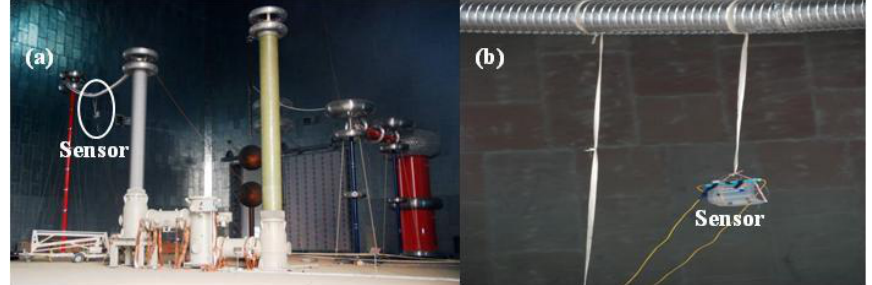
Figure 26. VFTO field measurement: ( a ) Overall configuration; ( b ) Setup of the sensor.